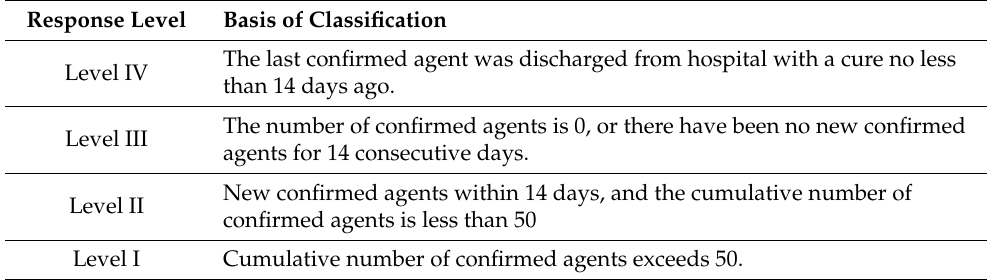
Table 2. Criteria for classifying government emergency response